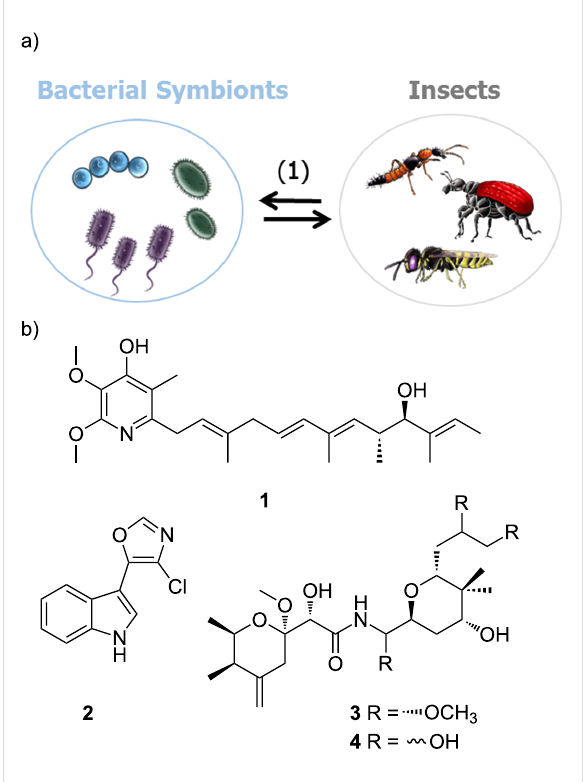
Figure 3: a) Interactions between bacterial (endo)symbionts and insects with both partners benefiting from the interactions (1). b) Defensive secondary metabolites isolated from bacterial symbionts: piericidin A1 ( 1 ), streptochlorin ( 2 ), pederin ( 3 ), and diaphorin ( 4